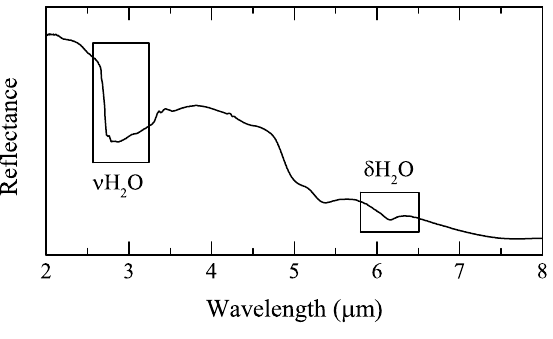
Figure 3. Average infrared spectra of the calcined kaolin samples. The boxes highlight the spectral regions where the water features are